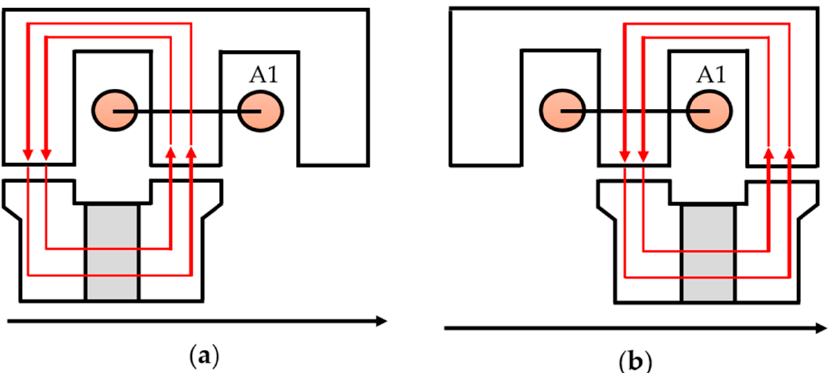
Figure 2. Working principle of the RPM-FS machine ( a ) rotor position A (at 0 electric degrees), and ( b ) rotor position B (at 150 electric degrees).